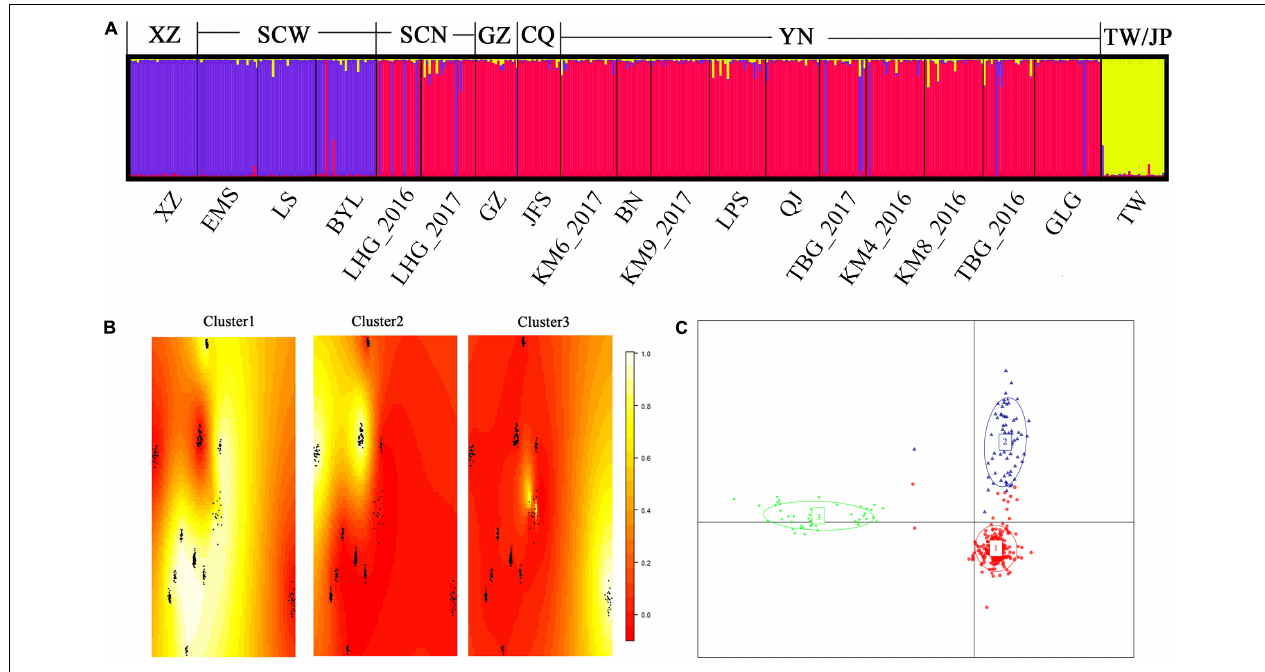
FIGURE 2 | Results of using microsatellite markers with three clustering methods to analyze the 19 Parantica sita populations. (A) A Bayesian approximation conducted in STRUCTURE. The letters below the bar plot are the geographic populations (see Supplementary Table 1 ) and the letters above are the main geographical distribution areas corresponding to the cluster. XZ: Tibet; SCW: western Sichuan; SCN: northern Sichuan; GZ: Guizhou; CQ: Chongqing; YN: Yunnan; TW/JP: Taiwan Island/Japanese archipelago. Each vertical bar represents an individual and different colors represent speculative clusters. (B) A spatial Bayesian model-based approach in TESS. In each heat map, yellow represents individual assignment probability close to 1 while red indicates individual assignment probability close to 0. The 19 P. sita populations gathered into three clusters: Cluster1 was distributed mainly in Yunnan, Guizhou, Chongqing, and northern Sichuan; Cluster2 mainly in Tibet and western Sichuan; and Cluster3 exclusively on Taiwan Island and the Japanese archipelago. (C) Discriminant analysis of principal components. Each dot represents an individual and each color represents a cluster. All populations gathered into three groups: Cluster1, mainly distributed in Yunnan, Guizhou, Chongqing, and northern Sichuan; Cluster2, mainly distributed in Tibet and western Sichuan; and Cluster3, distributed on Taiwan Island and the Japanese